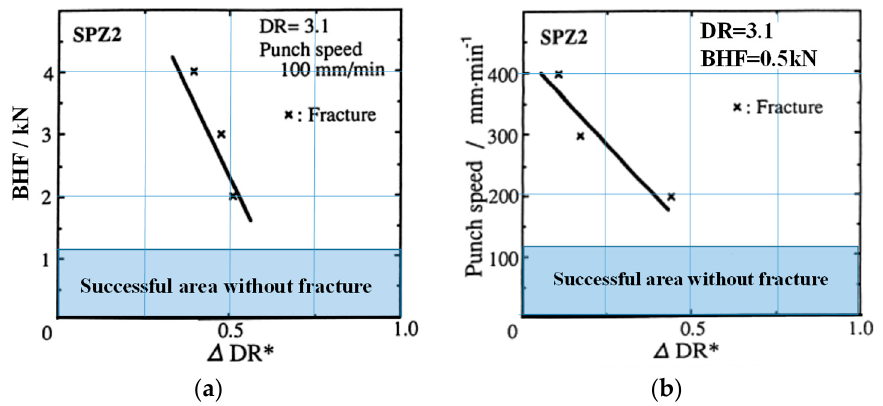
Figure 9. Effects of BHF and SPD on the fracture limit obtained in the warm superplastic deep drawing experiment (DR = 3.1). ( a ) Fracture limit BHF, ( b ) fracture limit SPD.